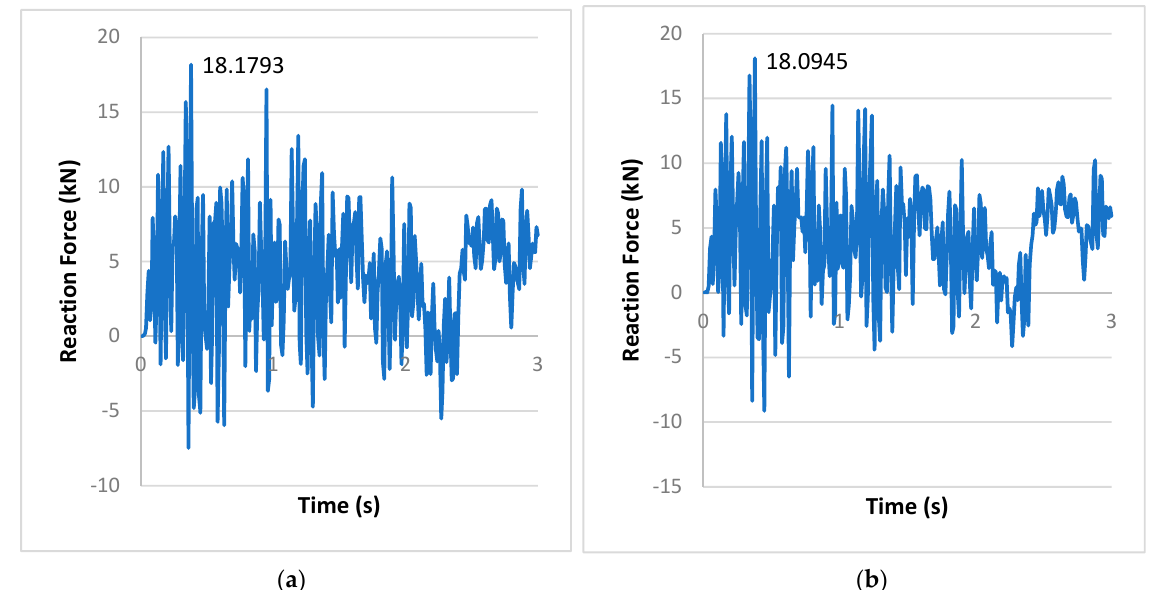
Figure 27. The comparison of the reaction force of fixed-support in the time-history analysis under different FA dosages ( a ) 0% FA, ( b ) 20% FA.